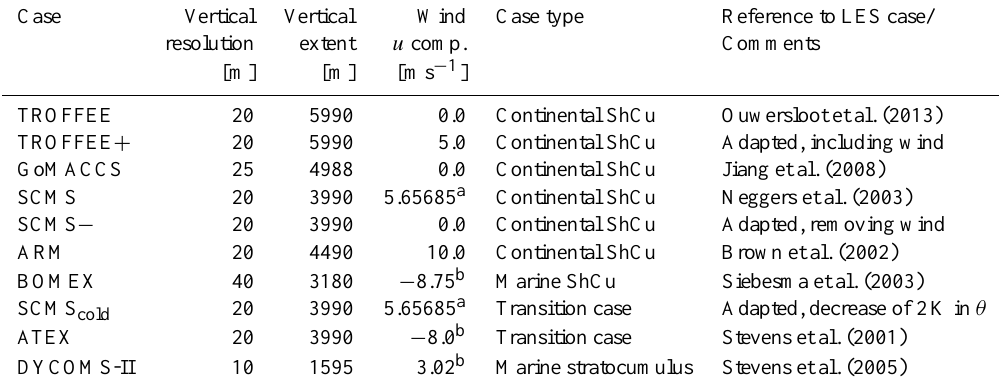
Table 1. Experimental setup of the shallow cumulus and stratocumulus cases. Case Vertical Vertical Wind Case type Reference to LES case/ resolution extent u comp. Comments [m] [m] [ms − 1 ] TROFFEE 20 5990 0.0 Continental ShCu Ouwersloot et al. (2013) TROFFEE + 20 5990 5.0 Continental ShCu Adapted, including wind GoMACCS 25 4988 0.0 Continental ShCu Jiang et al. (2008) Neggers et al. (2003) Adapted, removing wind Brown et al.